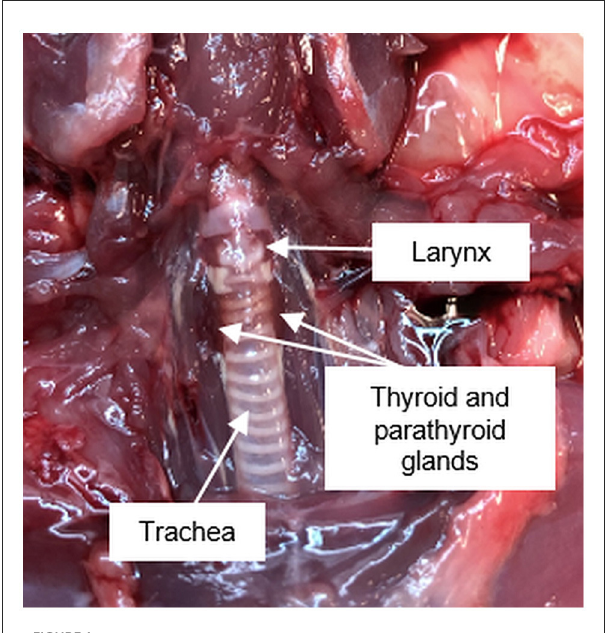
FIGURE1 Anatomical position of the pharyngeal and ventral neck region of a Sprague Dawley